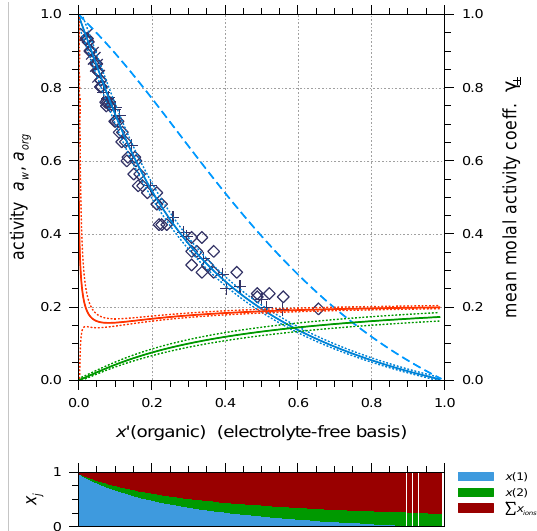
Fig. 11. Water activity measurements and AIOMFAC calculations for the system water (1)+malonic acid (2)+ ( NH 4 ) 2 SO 4 (3). All mixtures are at a 1 : 1 molar ratio of malonic acid: ( NH 4 ) 2 SO 4 . Ex- perimental bulk data for a w at 295K ( ) by Choi and Chan (2002), EDB data at 298K ( ) by Ling and Chan (2008), and micro-Raman data at 297K ( ) by Yeung and Chan (2010). Calculated curves at 298K: a w (solid blue), a org of malonic acid (solid green), γ ± of ( NH 4 ) 2 SO 4 (solid red), and a w of salt-free mixture (dashed blue). The dotted curves bordering the solid curves in the corresponding colors represent AIOMFAC sensitivities with respect to x tol = 0 .